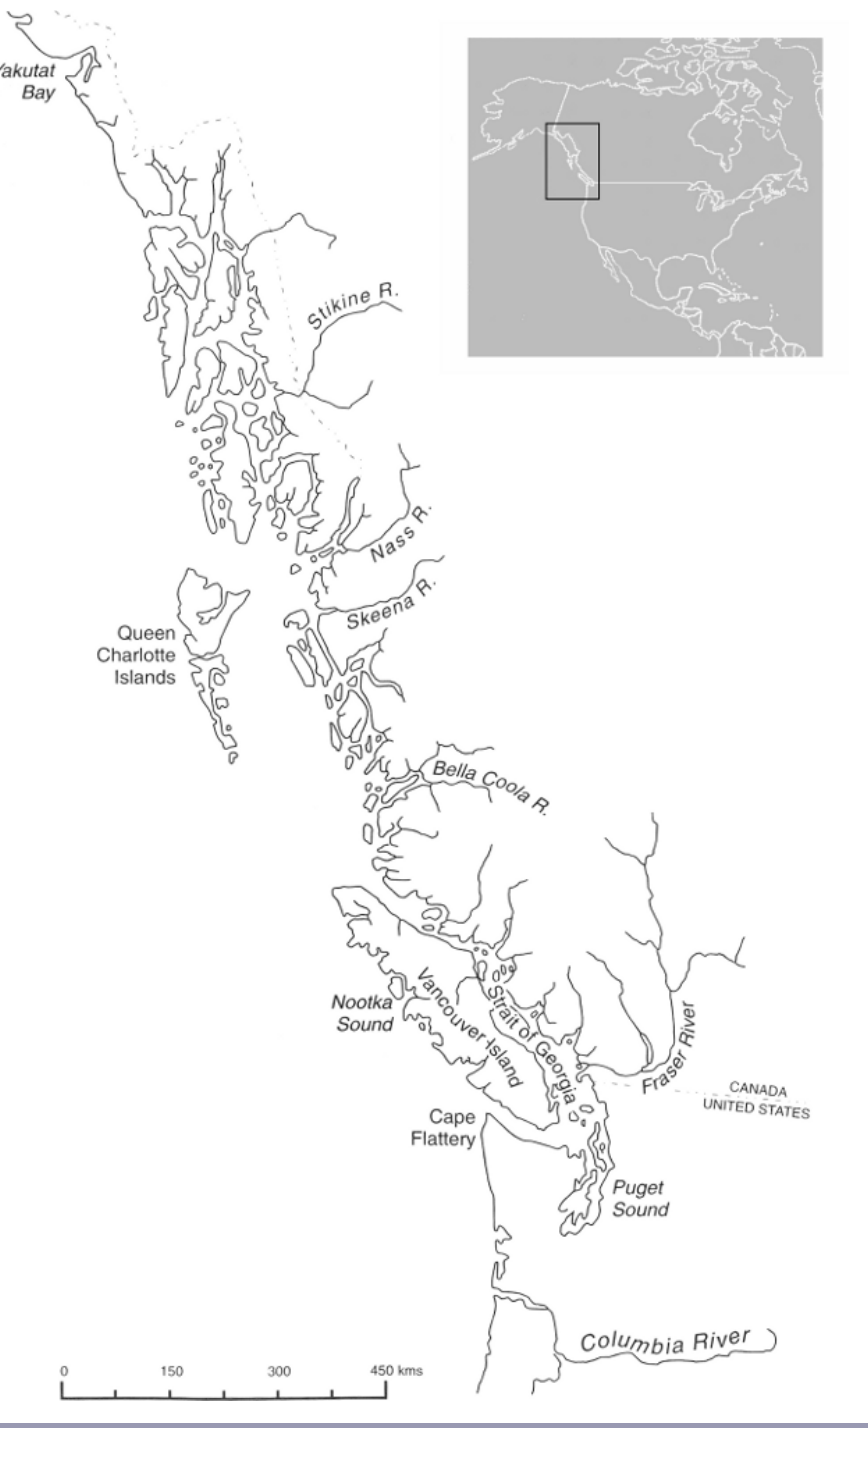
Fig. 1. The Northwest Coast. Reprinted with permission from University of California